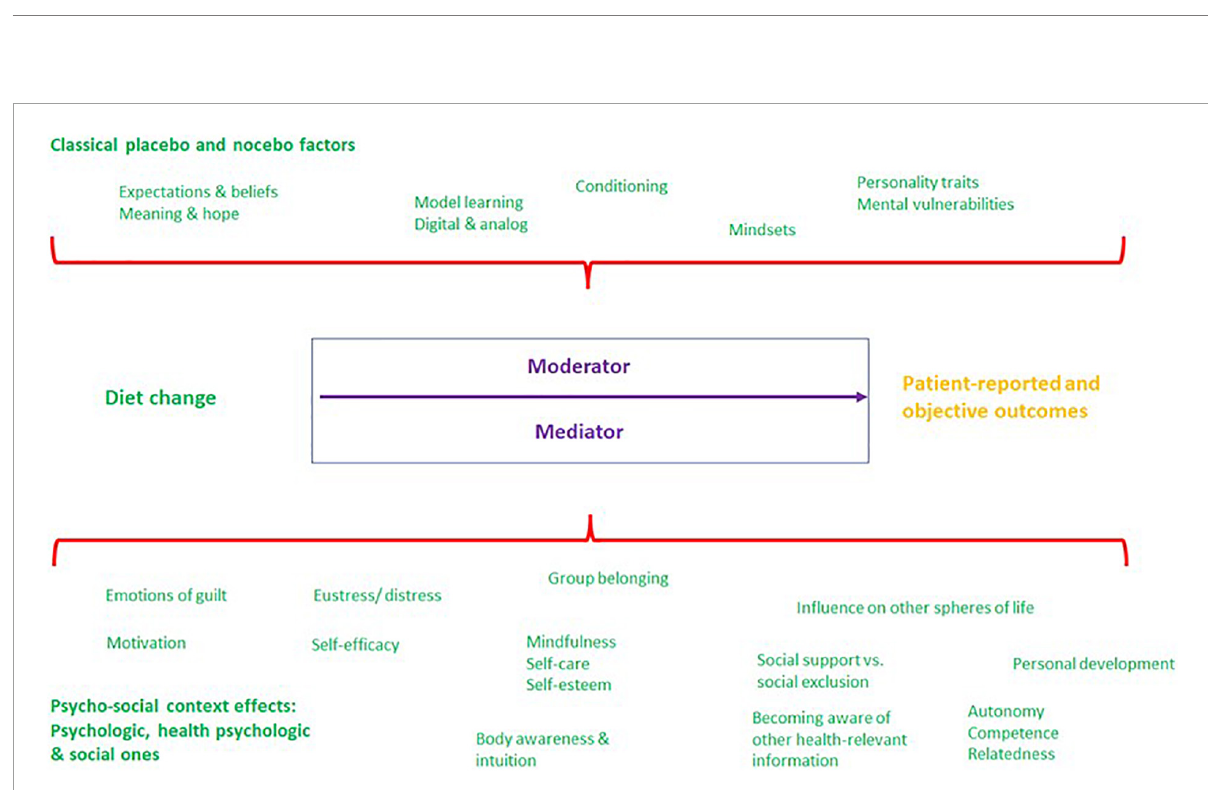
FIGURE4 Classical placebo- and nocebo-like as well as further psychosocial context factors acting as moderator and/or mediator variables (definition see below in section 4.1) that may have a positive and/or negative impact on patient-reported and objective outcomes in diet changes (source: own